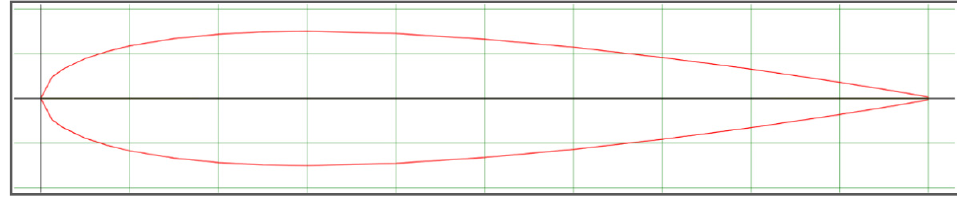
Figure 7. NACA 0015 blade profile for hydro-turbine [51].